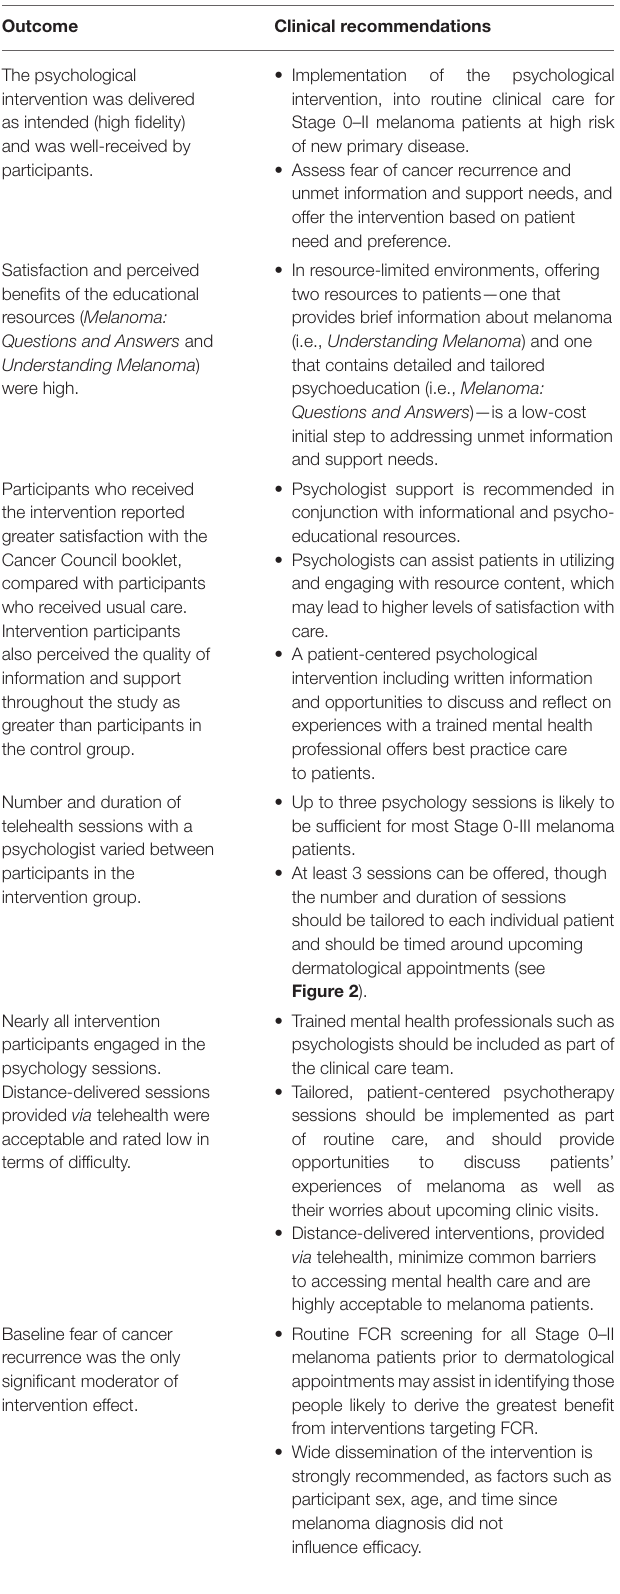
TABLE 8 | Clinical recommendations based on outcomes of the process